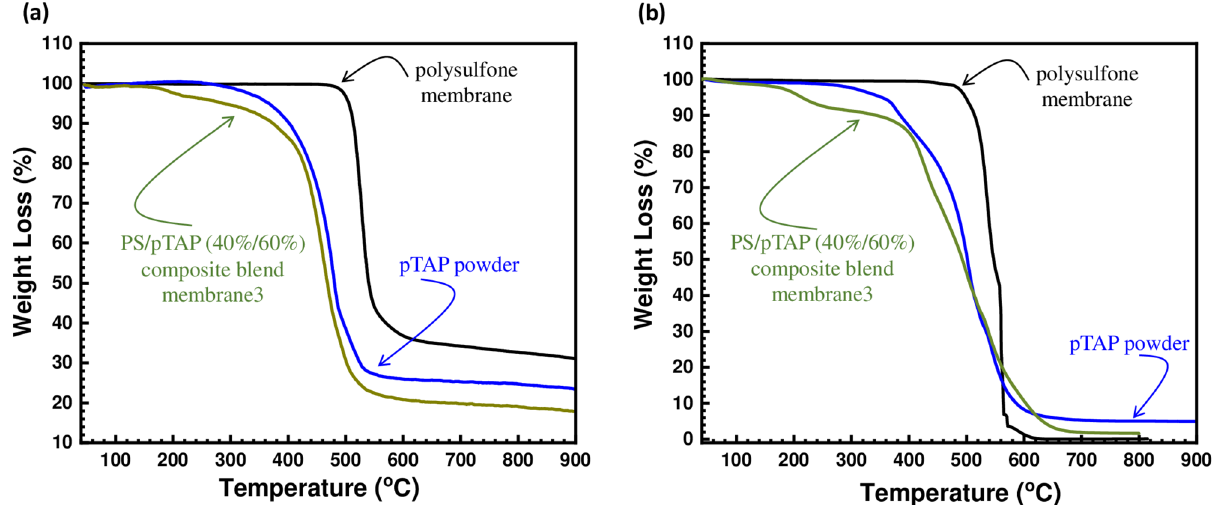
Figure 8. Thermal stability of polymeric based on polysulfone membrane; pTAP powder; and PS/pTAP (40%/60%) composite blend membrane in (a) in inert atmosphere and (b) oxygen